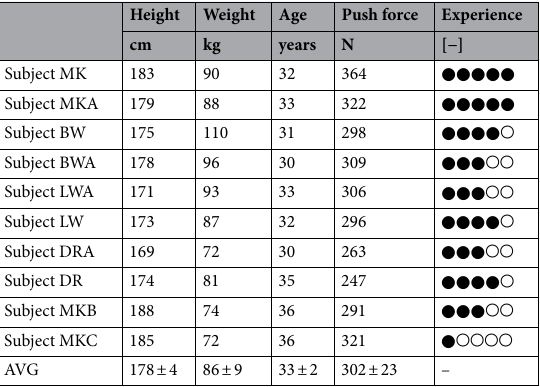
Table 1. Comparison of test subject anthropometric features and the level of experience in wheelchair operation. Mean values determined at 95% confidence interval (p =